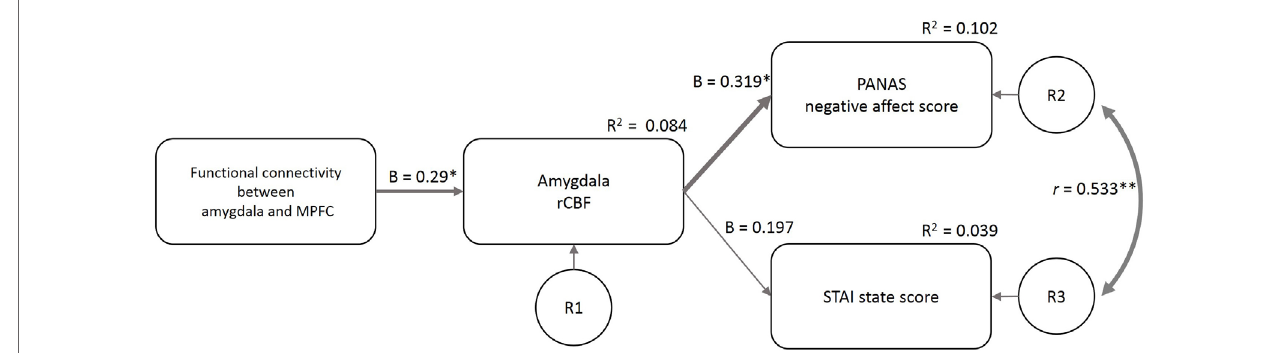
FigUre 5 | Structural equation modeling of psychological and neuroimaging variables. The functional connectivity between the amygdala and MPFC predicted the amygdala rCBF, which further predicted the PANAS-NA and STAI-S scores. The model included the data of the four sleep conditions ( n = 58). β , standardized coefficient; R 2 , square of multiple correlation coefficient; r , correlation coefficient; R1–3, residual of each endogenous variable; FC amg–MPFC , functional connectivity between the amygdala and medial prefrontal cortex; rCBF, regional cerebral blood flow; PANAS-NA, Positive And Negative Affect Schedule-Negative Affect score; STAI, State-Trait Anxiety Inventory-State Anxiety score. † p < 0.1, * p < 0.05, ** p <